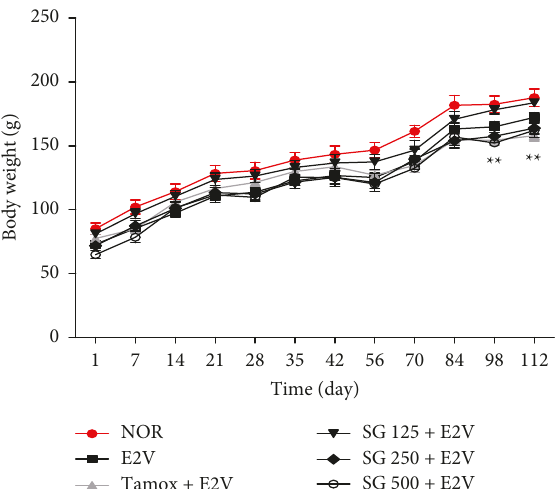
Figure 2: Body weight of rats after 16 weeks of treatment with different substances. NOR � Normal control treated with distilled water; E2V � E2V-control treated with distilled water; SG +E2V � Animals treated with the S. gilo hydroethanolic extract at the doses of 125, 250, and 500mg/kg BW. TAMOX +E2V � Animals treated with tamoxifen (3.3mg/kg BW); all groups except the normal group (NOR) received chronic administration of E2V at the dose of 1mg/kg BW. Data are represented as mean ± SEM ( n � 6). ∗∗ p < 0 . 01 as compared to the negative control.